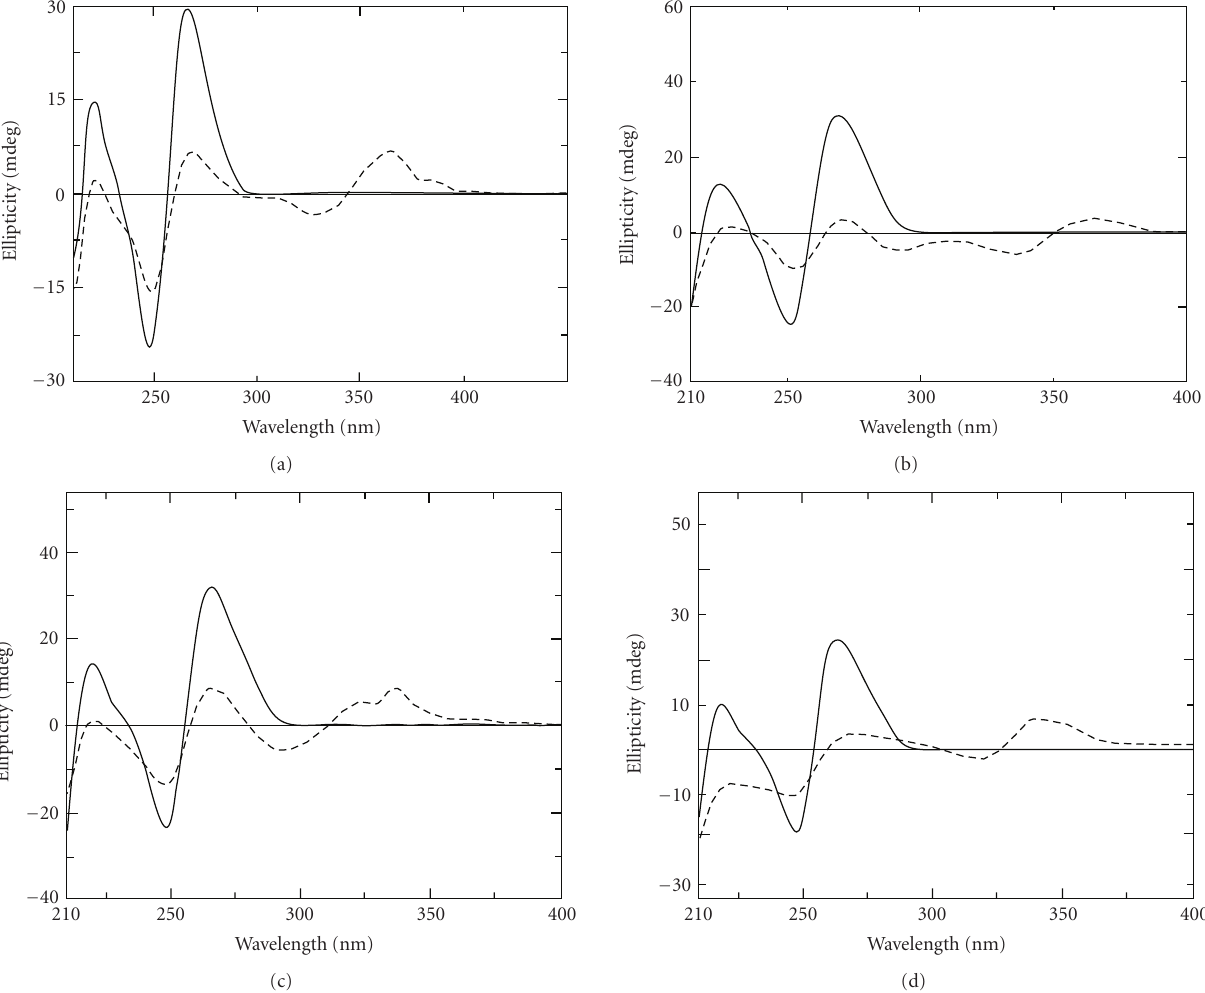
Figure 8: Circular dichroic spectrum of poly(A) helix (solid line) treated with (a) berberine (dashed line), (b) palmatine (dashed line), (c) coralyne (dashed line), and (d) sanguinarine (dashed line) at alkaloid/poly(A) molar ratio at saturation in each case. Partially reprinted from Nandi et al. [76], Giri et al. [77], Giri and Kumar [78], and Giri and Kumar [79] with permission from